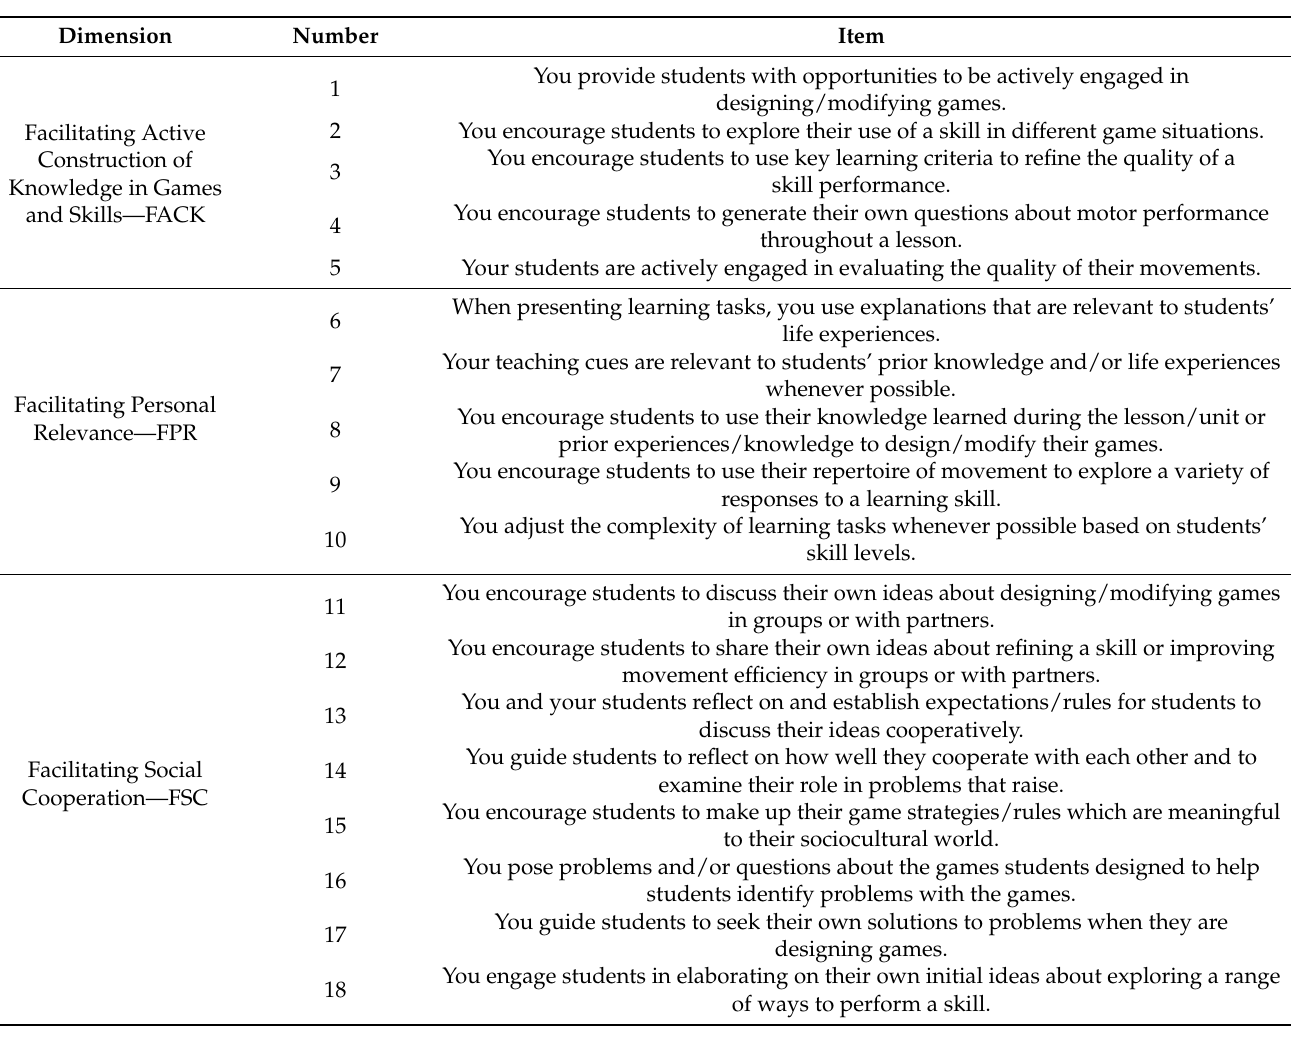
Table A1. Portuguese version of the